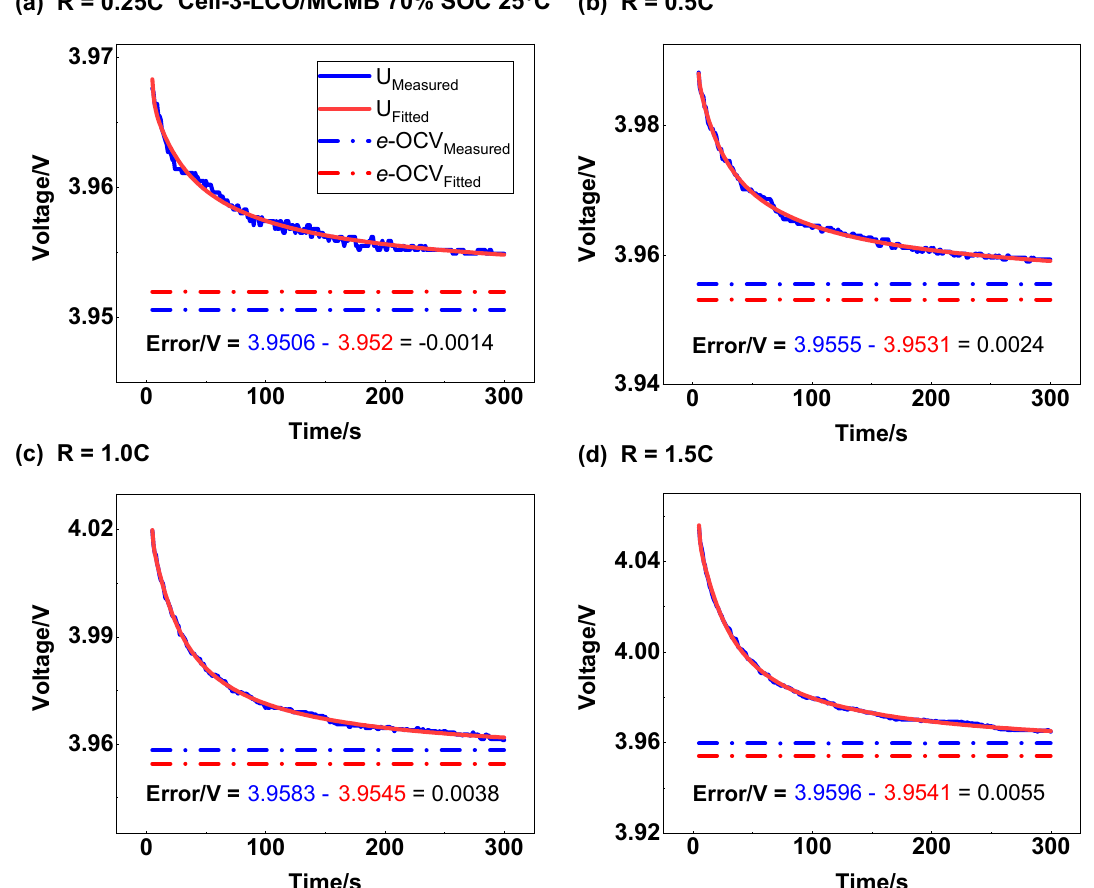
Figure 8. The validation result when the LCO/MCMB battery (Cell-3) is in charged state. Table 6. Validation results when the LCO/MCMB battery (Cell-3) is in charged state. Charge Rate